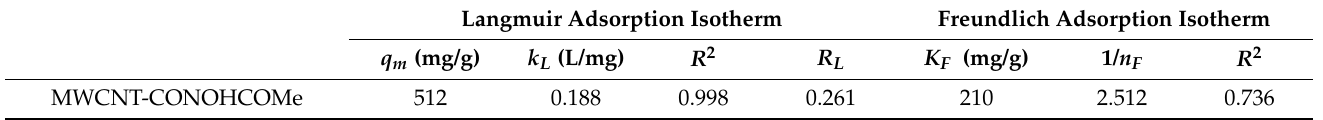
Figure 11. Langmuir and Freundlich isotherm models for the adsorption of lead onto ( A ) and ( B ) (adsorbent dose, 0.01 mg/mL). Table 4. Langmuir and Freundlich parameters for Pb(II) adsorption onto MWCNT-CONOHCOMe.